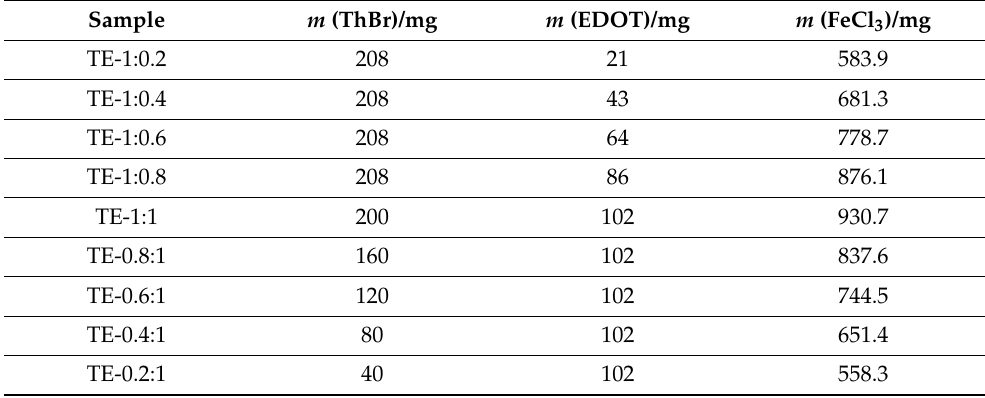
Table 1. Reactant and oxidant quantities used in different